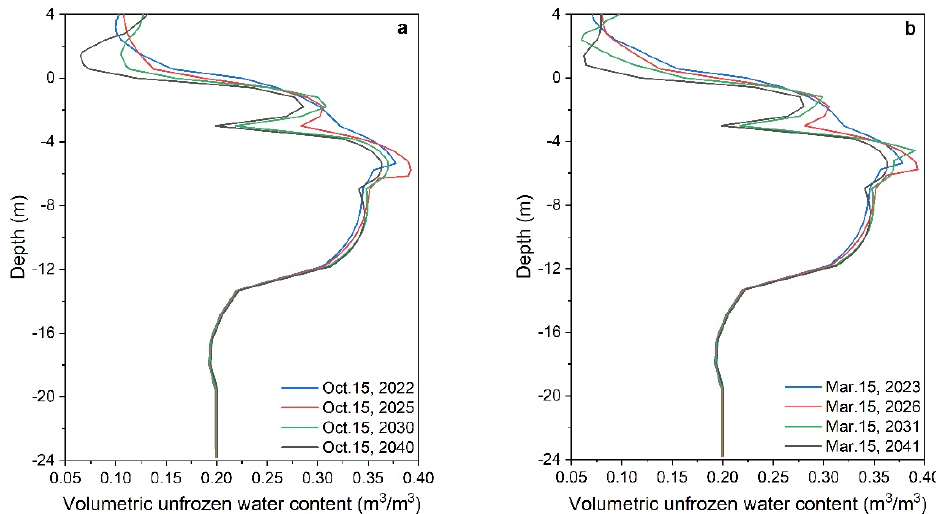
Figure 6. Vertical distributions of volumetric unfrozen water content under the road centerlines in warm and cold seasons in different years: ( a ) vertical distributions of volumetric unfrozen water content in warm seasons and ( b ) vertical distributions of volumetric unfrozen water content in cold seasons.